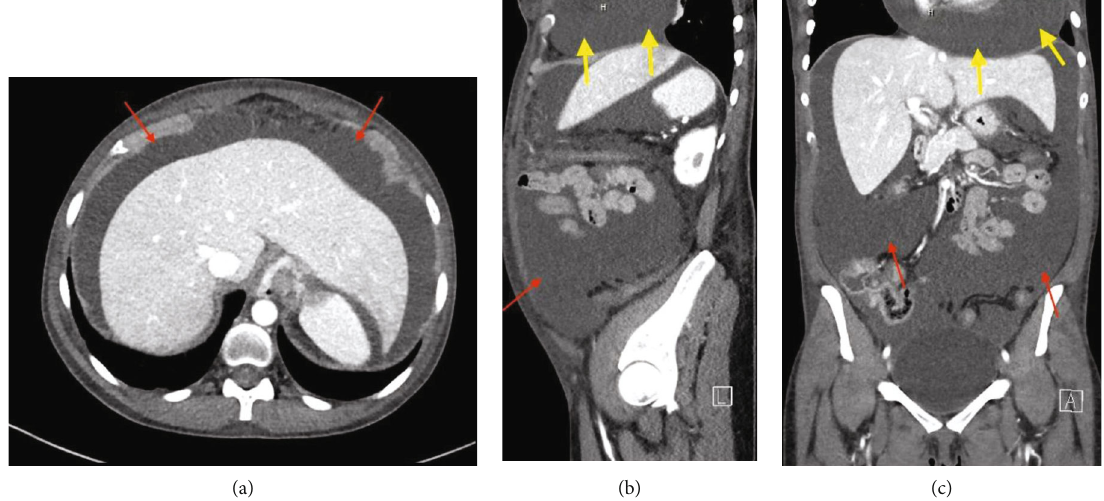
Figure 2: CT of the abdomen and pelvis with IV contrast on day 1. Mild bilateral basilar foci of atelectasis. Large pericardial e ff usion (yellow arrows in (b) and (c)). Large amounts of ascitic fl uid (red arrows in (a) – (c)). Mild stranding of the peritoneum